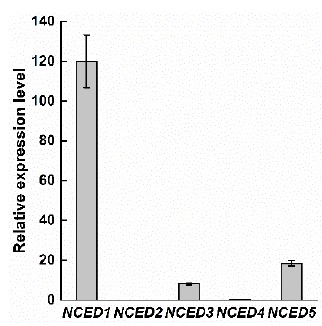
Figure A2. OsNCEDs expression of Chaling. The seeds were harvested at low temperatures in November 2017 and therefore cannot be compared.